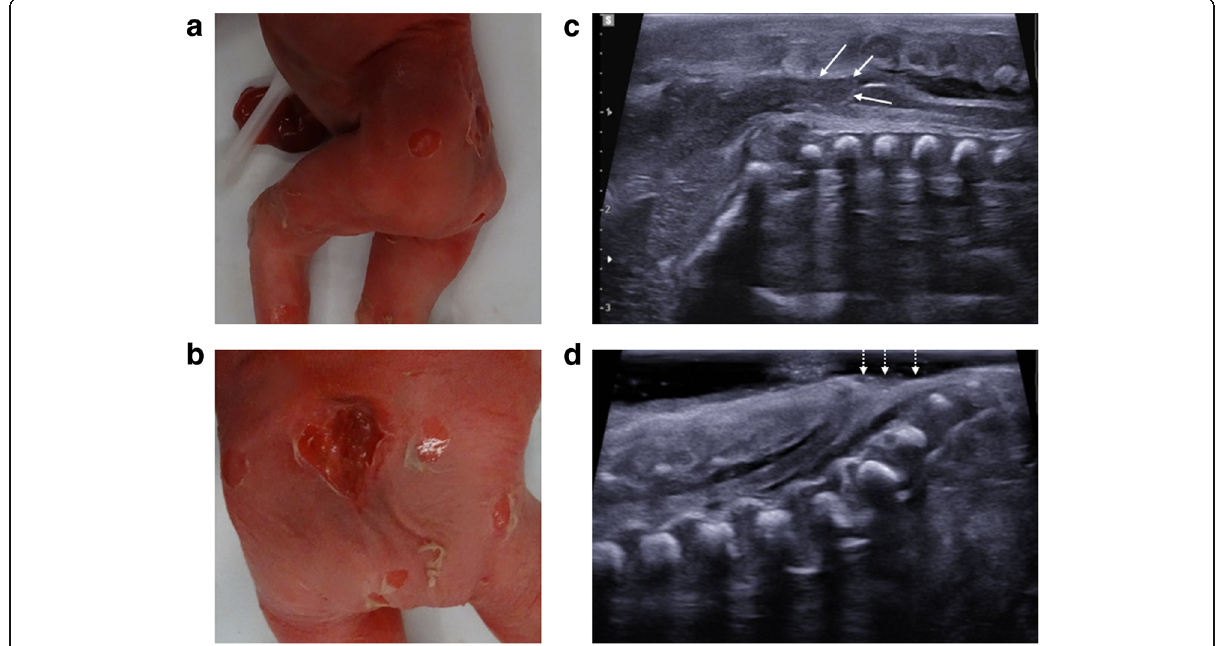
Fig. 1 Neural tube defect following termination of pregnancy in a foetus at 25weeks gestation. A small neural tube defect is identified on external examination at autopsy with the foetus viewed from the left side ( a ) and from behind ( b ). On the corresponding post-mortem ultrasound performed 4days after death, the sagittal view of the cranio-cervical junction ( c ) demonstrates herniation of the cerebellar tonsils (solid white arrows) into the upper cervical spinal canal. The sagittal ultrasound image of the lumbosacral spine ( d ) demonstrates the small neural tube defect (dashed